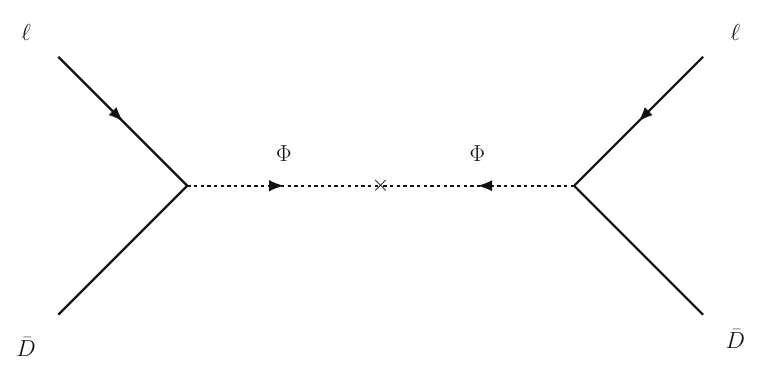
Figure 1 . Feynman diagram responsible for washout of lepton asymmetry. The arrows indicate the flow of the lepton